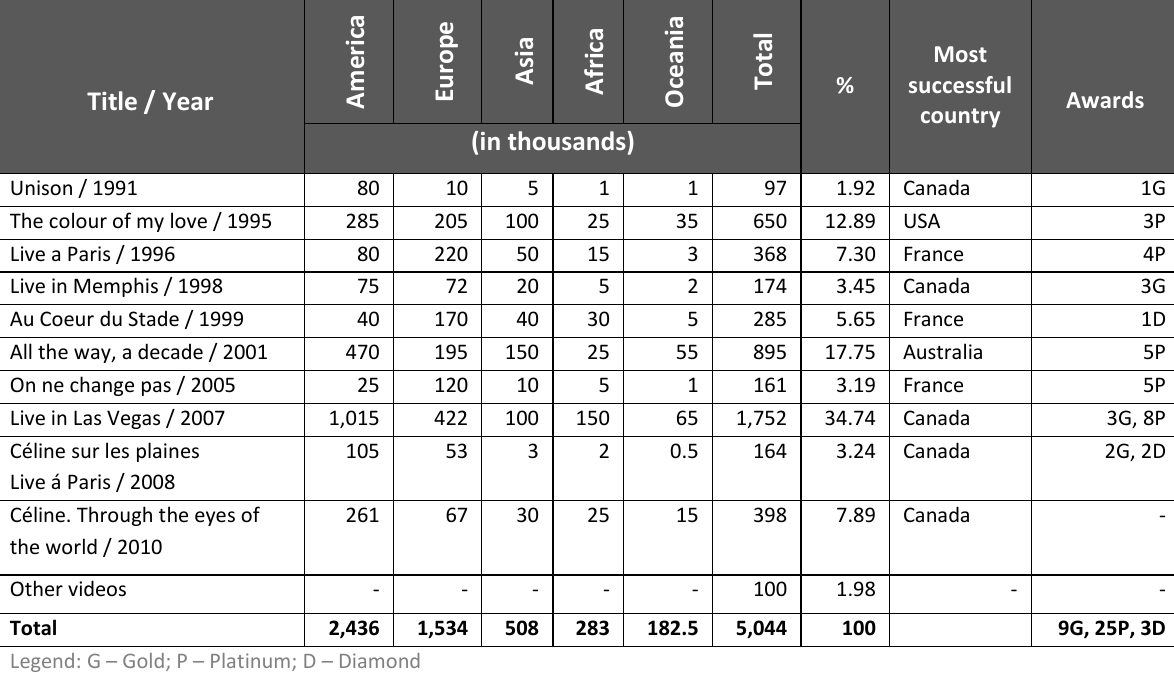
Table 5: Statistics on home videos sold worldwide with a continental approach (1991 – 2010)